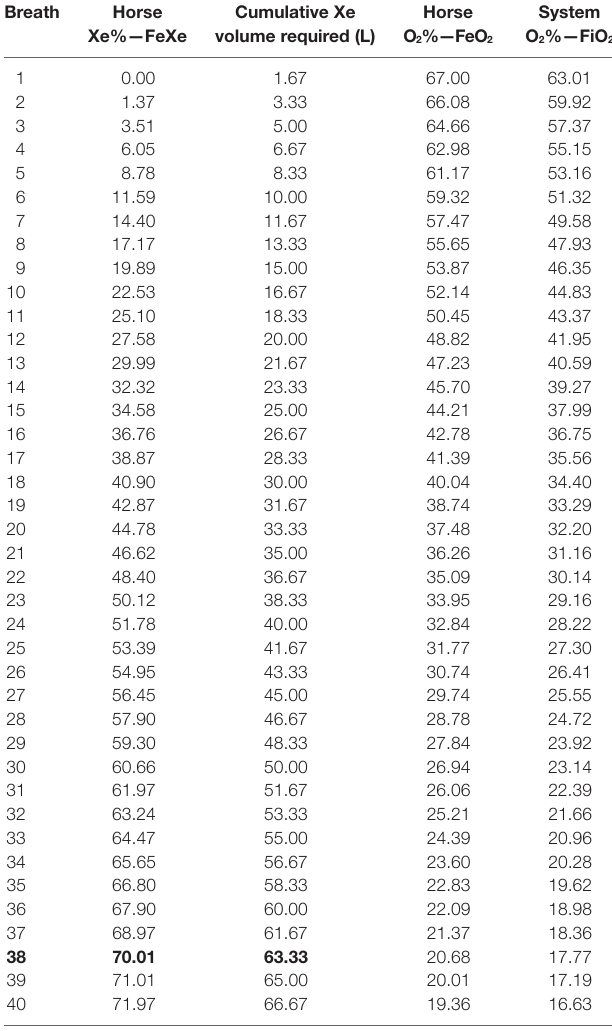
Table 2 | Modeling of wash-in phase. breath horse cumulative Xe Xe%—FeXe volume required